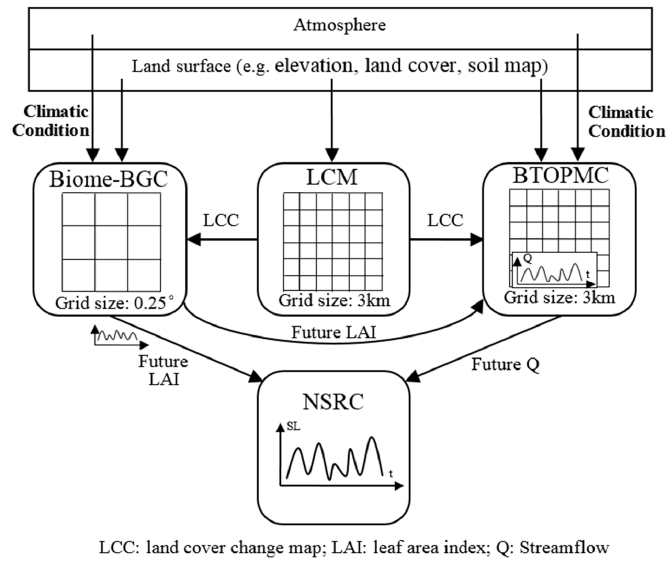
Figure 2. Model integration and data flow within models. Biome-BGC: Biome-BioGeochemical Cycle; LCM: Land Change Model; BTOPMC: Block wise use of TOPMODEL with Muskingum–Cunge